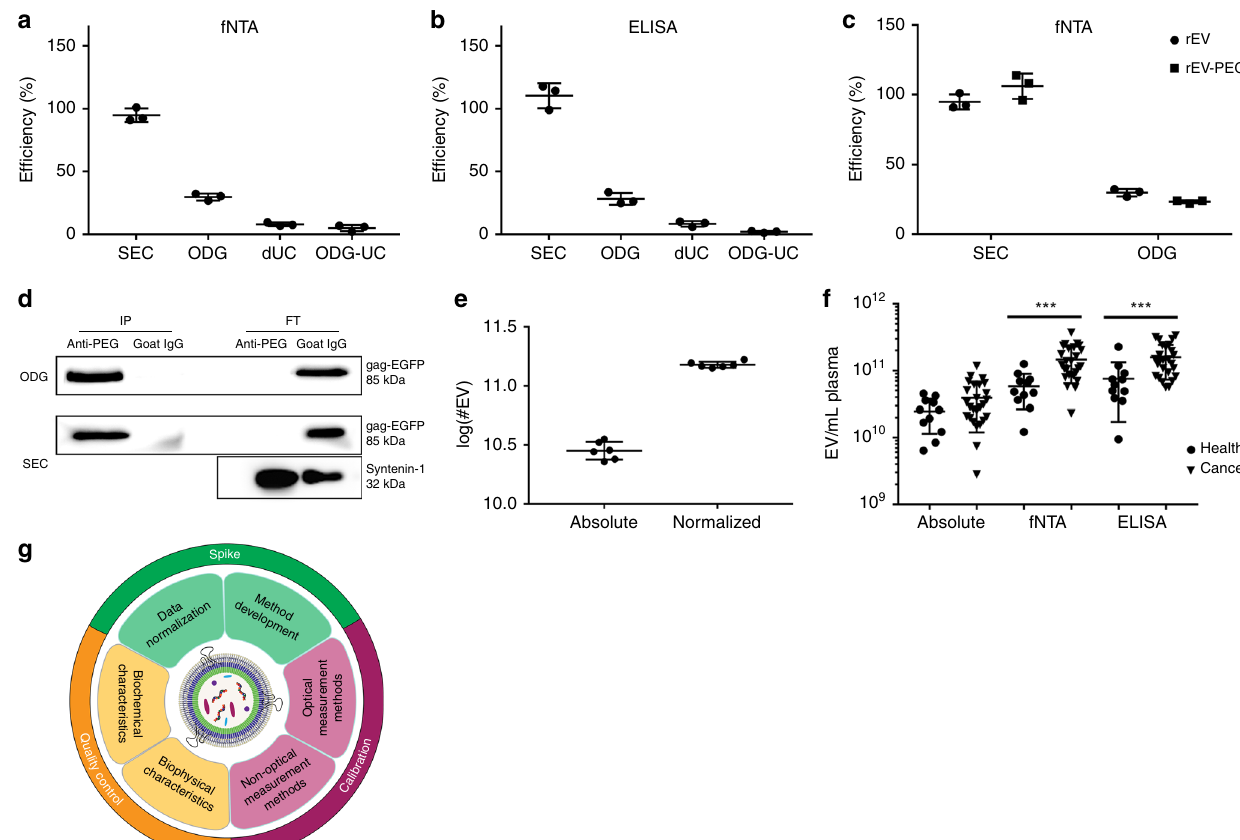
Fig. 5 Use of rEV in various applications. a Calculation of ef fi ciencies of EV separation methods from plasma by measuring spiked rEV (5 × 10 10 ) with fNTA and b an ELISA for p24, a subunit of the gag polyprotein ( n = 3). c Comparison of calculated EV separation ef fi ciencies for plasma by fNTA, making use of rEV or rEV-PEG ( n = 3). d Western blot analysis for EGFP and syntenin-1 of immune precipitated rEV-PEG and sample EV after separation from plasma by SEC or ODG centrifugation, making use of anti-PEG or non-speci fi c goat IgG coated magnetic beads (IP: immune precipitated, FT: fl ow through) (image representative of two biological replicates). e Log of the number of sample EV measured by NTA before and after normalization by rEV quanti fi cation with fNTA to reduce inter-user variability (graph representative of two biological replicates). f EV/mL plasma from healthy volunteers ( n = 11) and breast cancer patients ( n = 26) after separation by ODG centrifugation and normalization by rEV quanti fi cation with fNTA and an ELISA for p24. *** P < 0.001 (Mann – Whitney test). g Schematic overview of various rEV applications. All data depicted in a , b , c , e , f are (mean, SD). Source data are provided as a source data fi le and supplementary tables 1 and 2 (Fig. 5a, b). The number of rEV spiked (1 × 10 8 – 1 × 10 11 ) did not number of sample EV and rEV were quanti fi ed by NTA and impact recovery calculations (supplementary fi g. 11). In addition, fNTA, respectively. The inter-user variation, expressed as CV, recovery calculations were independent of the use of rEV or rEV- showed a 66% reduction (from 17.5% to 5.9%) due to normal- PEG (Fig. 5c). After separation of rEV-PEG and sample EV from ization for rEV recovery ef fi ciencies (Fig. 5e) (supplementary plasma by SEC and ODG centrifugation, the use of anti-PEG table 1). antibody-coated magnetic beads allowed for a complete segregation of rEV-PEG from sample EV (Fig. 5d). The coef fi cient of variation (CV), a measure for method rEV accurately enumerate EV in patient samples . Sample EV repeatability de fi ned by the SD divided by the mean (expressed as and spiked rEV (2 × 10 10 ) were separated by ODG centrifugation a percentage), is a pertinent statistic for accurate data interpreta- from 2 mL of plasma of breast cancer patients ( n = 26) and sex- tion of EV separation and quanti fi cation methods. In general, matched healthy volunteers ( n = 11), and were measured by NTA intra-method CV should be less than 10%. Using rEV, the intra- and fNTA, respectively. The average, normalized sample EV method CV for the EV separation methods SEC, ODG concentration per mL plasma was increased by 2.5 fold (1.46 × centrifugation and dUC could be calculated and were, respec- 10 11 vs 5.83 × 10 10 ) ( p = 0.0002, Mann – Whitney test) in breast tively, 5.7%, 9.2% and 18.0% as measured by fNTA ( n = 3) cancer patients compared to healthy individuals. In contrast, (Fig. 5a). The intra-method CV for rEV quanti fi cation methods absolute counts did not reveal a signi fi cant difference (3.91 × 10 10 fNTA, RT-qPCR and anti-p24 ELISA were, respectively, 5.8%, vs 2.47 × 10 10 ) ( p = 0.1410, Mann – Whitney test). Normalization 0.8% and 5.7% (Fig. 3c, g, j). To demonstrate the applicability of was independent from the rEV quanti fi cation method used since rEV to de fi ne and mitigate for inter-user variations, 1 × 10 10 rEV implementation of a p24 ELISA to quantify rEV provided were spiked in plasma and separated by ODG centrifugation ( n equivalent results in breast cancer patients compared to healthy = 6). Inter-user variation was induced by replacing de fi ned individuals (1.59 × 10 11 vs 7.55 × 10 10 ) ( p = 0.0009, Mann – sample volumes with PBS (see material and methods). The total Whitney test) (Fig. 5f) (supplementary table 2). NATURE COMMUNICATIONS| (2019) 10:3288